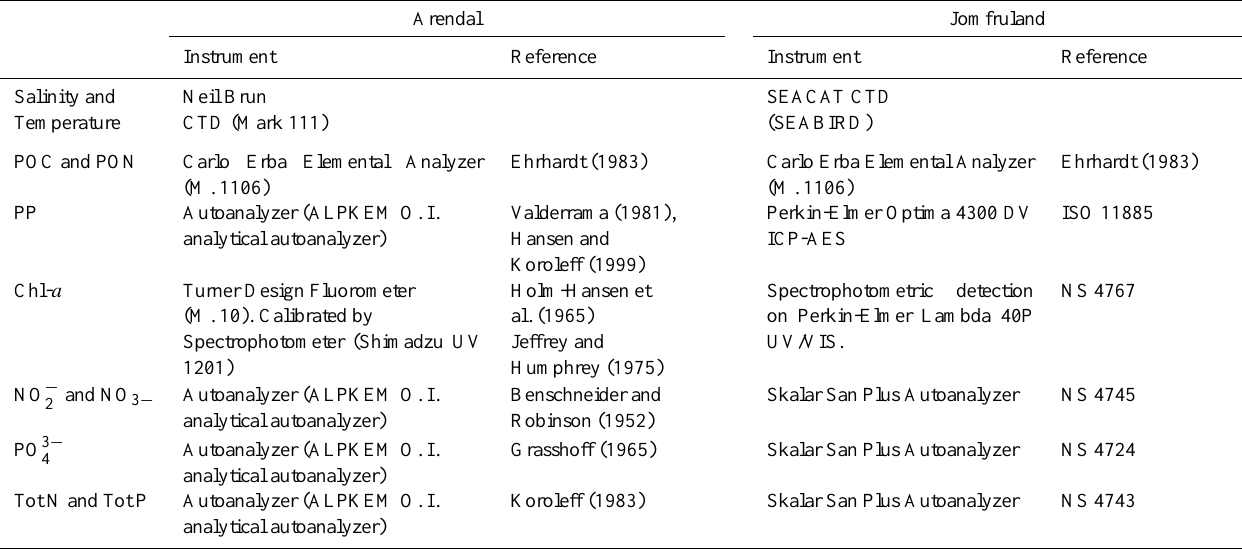
Table 1. Overview of analytical protocols for Arendal and Jomfruland